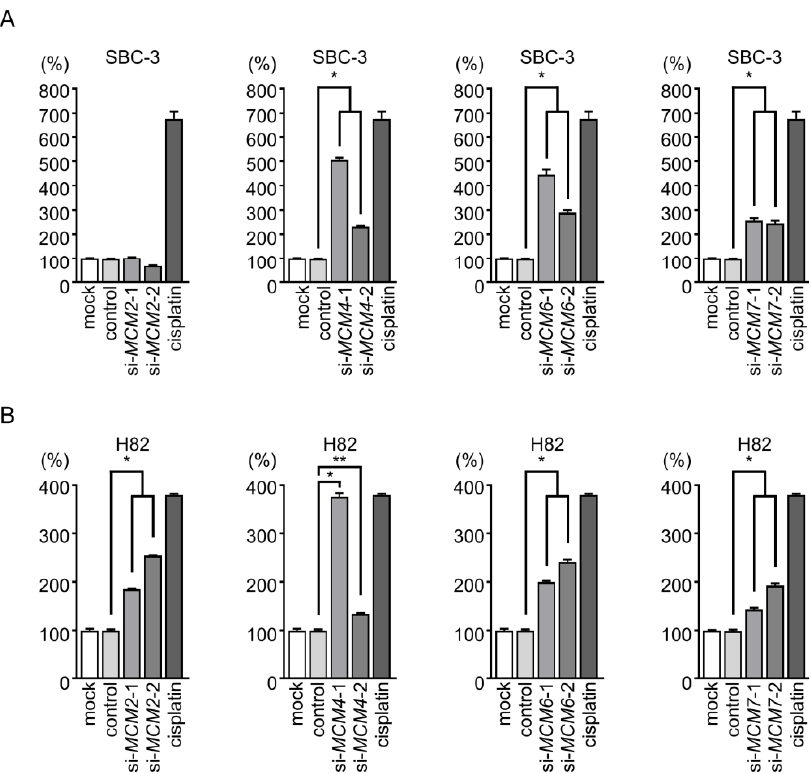
Figure 6. Effect of siRNA-mediated knockdown of MCM family members on apoptosis in SCLC cells. In both SBC-3 and H82 cells, the number of apoptotic cells was increased by transfection of siRNAs targeting MCM4 , MCM6 , or MCM7 . Transfection of the MCM2 -specific siRNAs caused apoptosis only in H82 cells. *, p < 0.0001, **, p < 0.01.